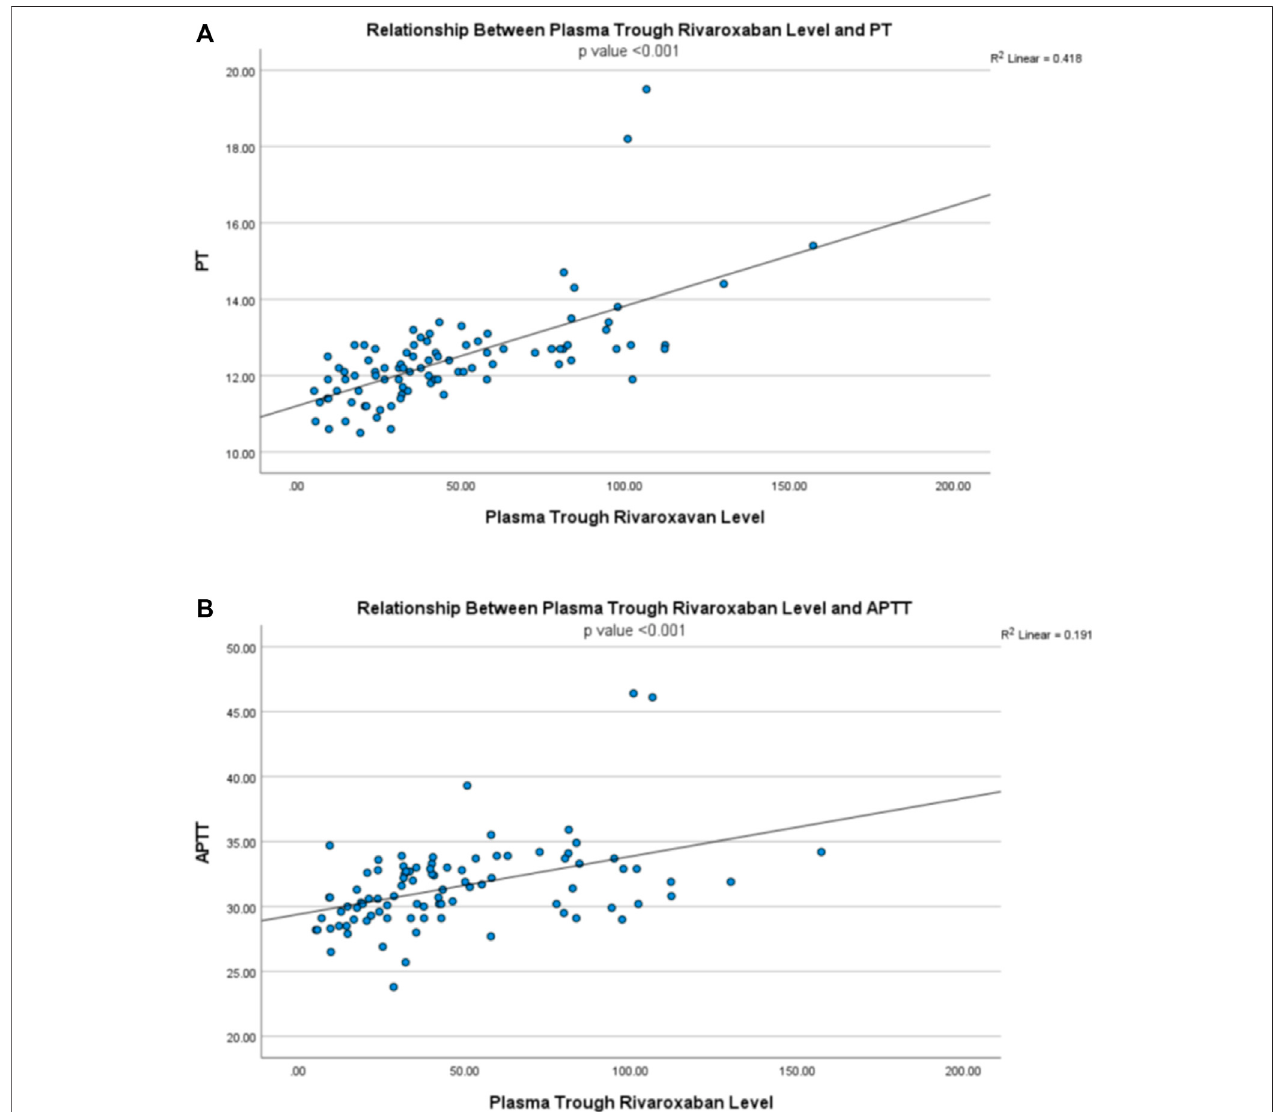
FIGURE 5 | Relationship between plasma trough rivaroxaban level and (A) prothrombin time (PT) and (B) activated partial thromboplastin time (APTT).